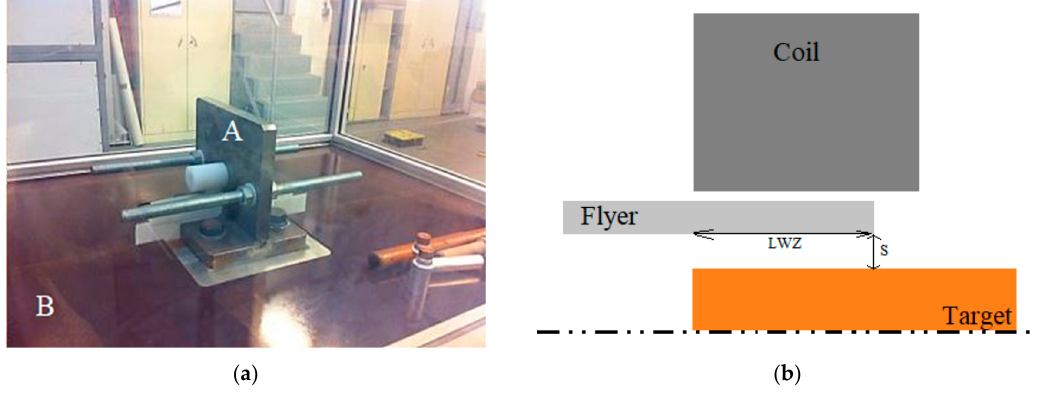
Figure 1. The setup applied for the performance of MPW in this study: ( a ) the coil assembly (A) on the station of the equipment, ( b ) the arrangement of coil-flyer-target (that were kept constant in this study).